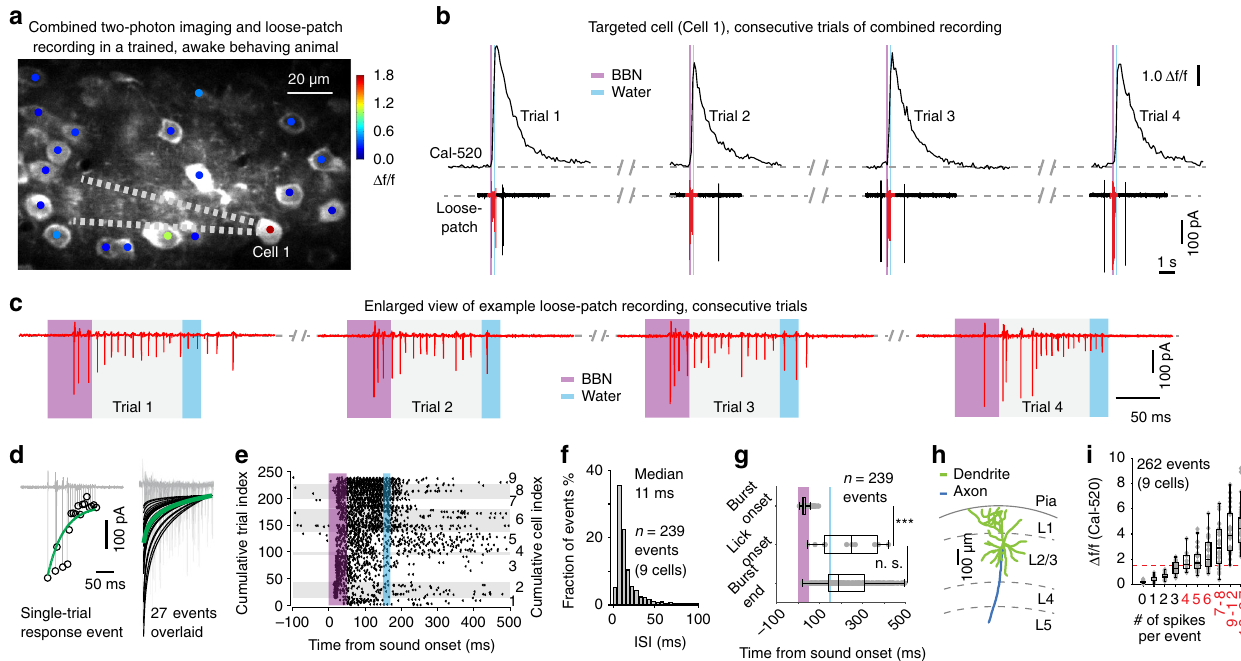
Fig. 3 Two-photon Ca 2 + imaging with Cal-520 and single-cell electrophysiology in trained, awake behaving animals. a Example of combined recording in a trained, behaving mouse. Light grey dotted lines illustrate the position of a micropipette (for loose-patch recording) targeting the cell marked by a red dot (pseudo-coloured response amplitude by two-photon Ca 2 + imaging with Cal-520). b Combined recordings on an example cell (Cell 1 in ( a )); upper traces (Cal-520 imaging) and lower traces (loose-patch, recorded in voltage-clamp mode) are displayed on the same temporal scale. c An enlarged view of the loose-patch recording with ~200 ms of data around the stimulation timepoints (same data as in ( b )). d One example response event (left subpanel) and 27 overlaid example events (three consecutive events per cell, nine cells, right subpanel) with exponential fi tting of data points of spike peaks (appearing as troughs in the recorded traces). Black lines: fi tting to individual events, green line: average of all fi ttings. e Spike raster plot of all trials for 9 bursting responsive cells (cells sorted by their average response strength). f Inter-spike interval (ISI) histogram for all the response events as in ( e ). g Box plots show the timing of burst onset, lick onset and burst end. P = 1.28e − 7 (Lick onset versus Burst onset), P = 0.98 (Lick onset versus Burst end), two- sided Wilcoxon rank-sum test, Bonferroni corrected, Burst n = 239 events, Lick n = 11 events, *** P < 0.001, n.s., P > 0.05. h Side-view projection of the 3D reconstruction of an example bursting responsive cell. i Box plots showing relations between single-trial Ca 2 + response amplitude and the number of spikes per response event, n = 21, 20, 29, 25, 10, 29, 26, 26, 28, 48 events, respectively, involving response events pooled from the nine cells shown in ( e – g ) and another seven non-bursting cells. The red dashed line indicates Δ f / f = 1.5. In this fi gure, violet shade: sound stimulation time, light blue shade: water pumping time. Boxes represent 25th and 75th percentiles (Q1 and Q3), i.e., interquartile range (IQR), central bars indicate the median, and whiskers indicate Q1-1.5 × IQR and Q3 + 1.5 ×